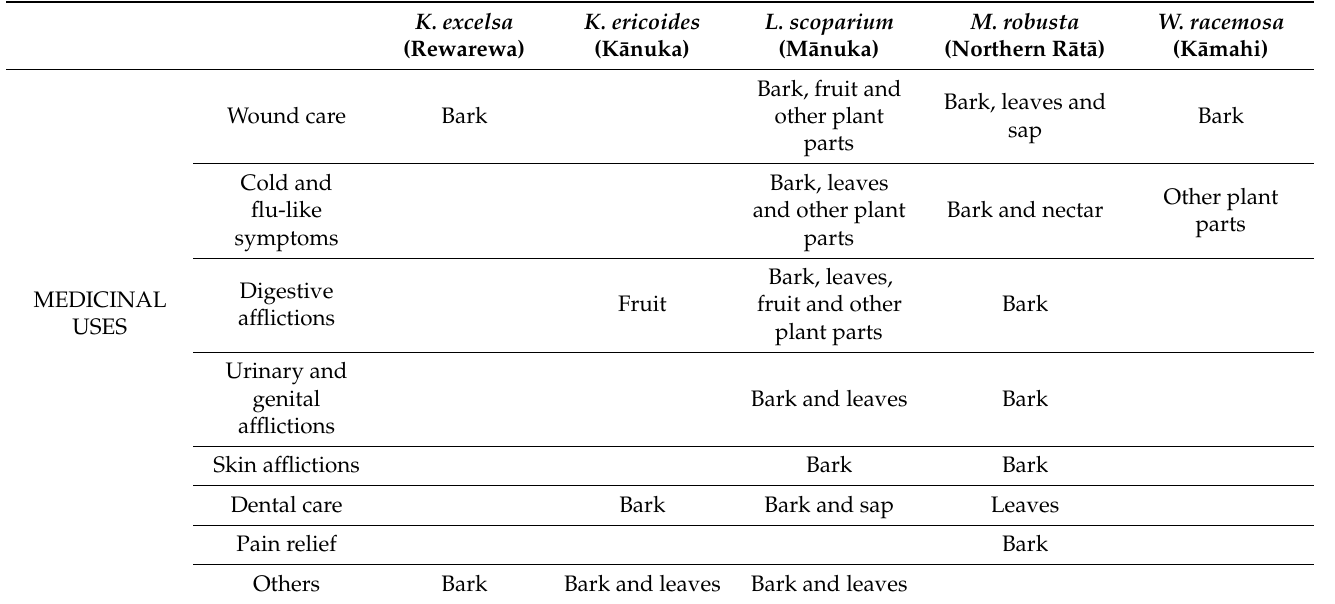
Table 1. Uses of rewarewa, k¯anuka, m¯anuka, northern r¯at¯a and k¯amahi in rongo¯a (traditional M¯aori medicine)